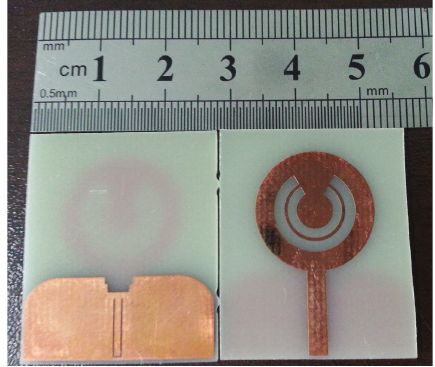
Figure 2: Photograph of the fabricated UWB antenna.